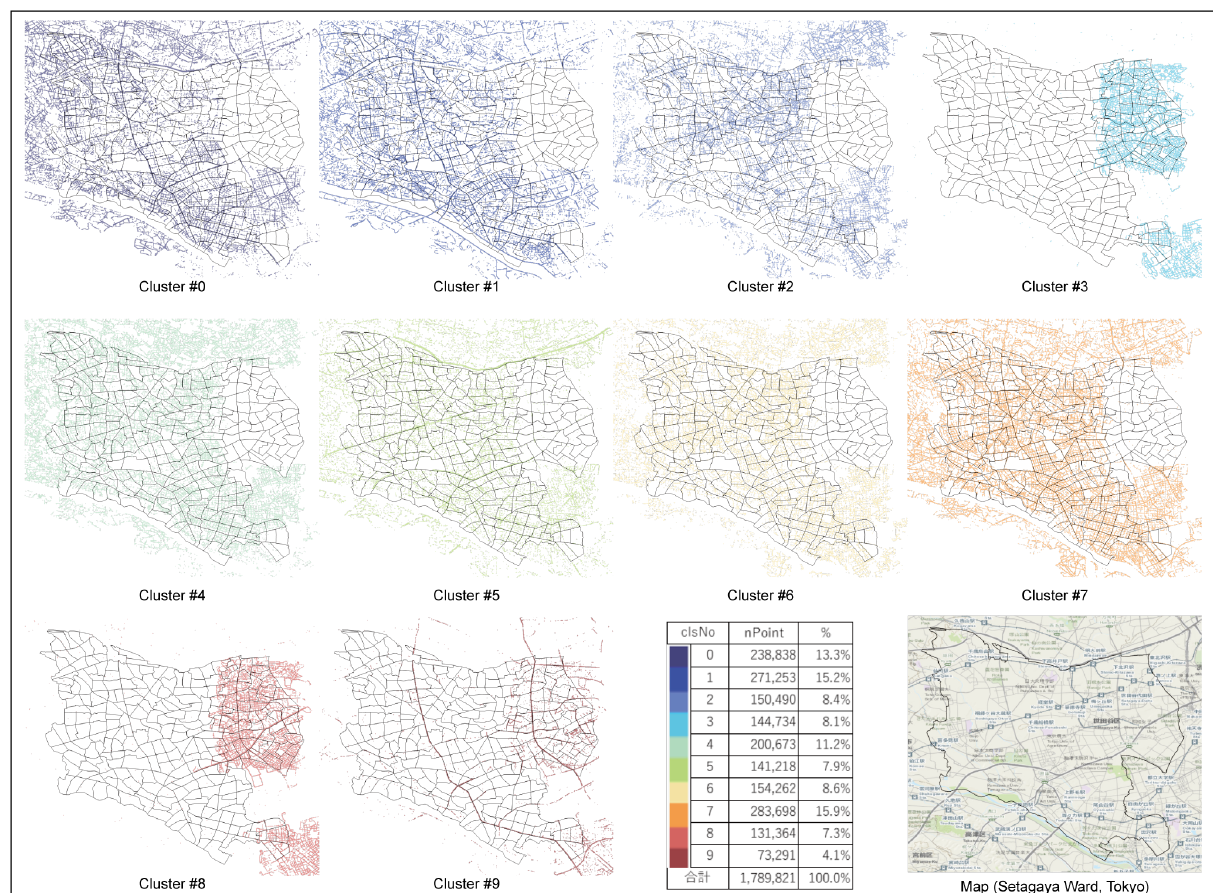
Figure 6. Clustering results of about 1.8 million images (database 1) the whole Setagaya Ward using PQk-means (number of clusters = 10).